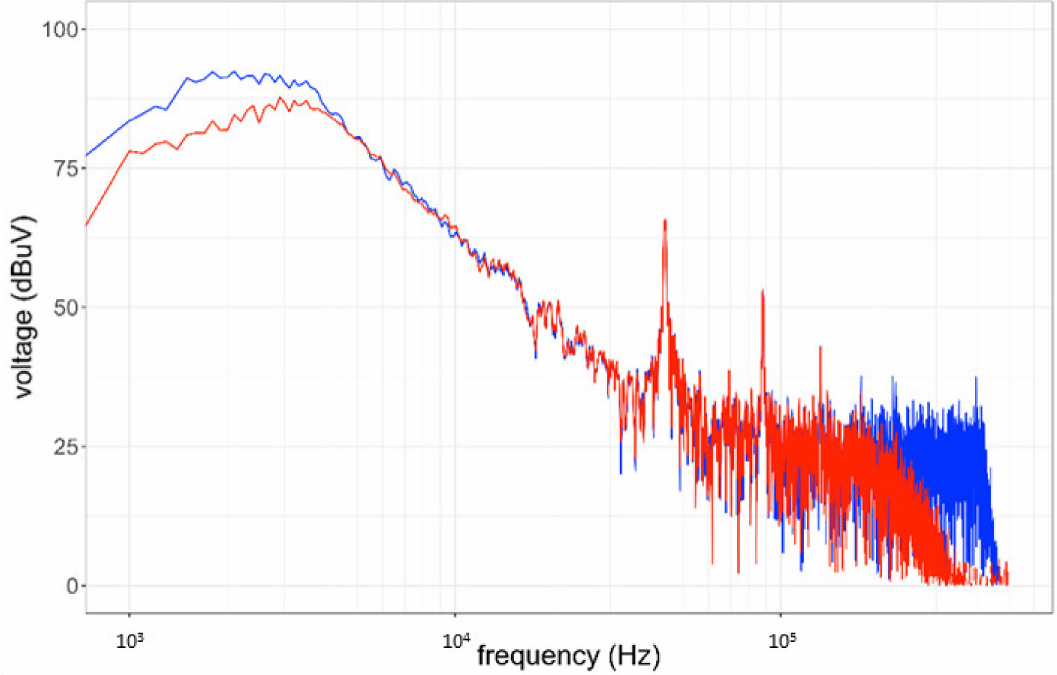
Figure 11. Comparison of the FFT spectra obtained from IMFs 2–5 extracted with EMD ( red ) and from the original signal ( blue